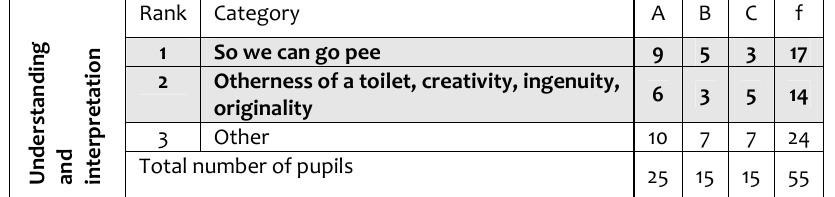
Table 14: Ranking order of categories of answers regarding understanding and interpretation of the message of the fifth example (Figure